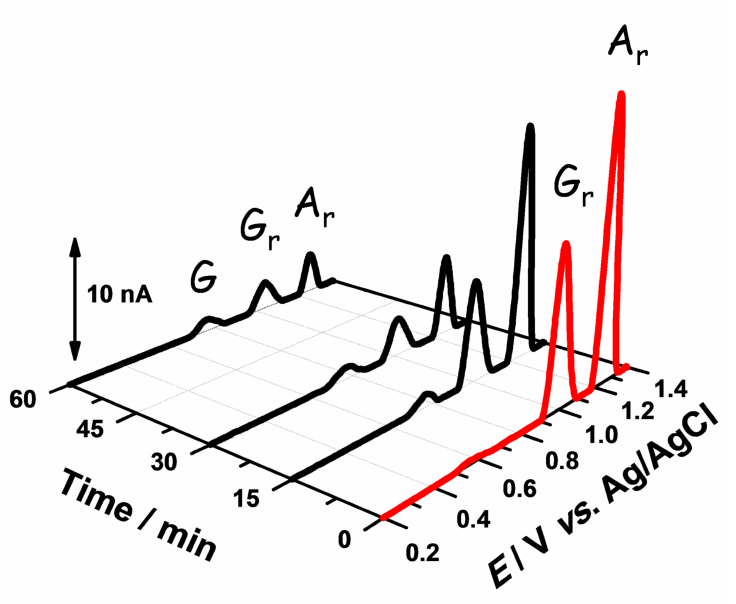
Figure 5. Baseline-corrected DPV at pH 4.5, obtained with a dsDNA–electrochemical biosensor, (red line) before and (black line) after incubation with 0.1 µ M miltefosine, during different time periods. Adapted from [80] with